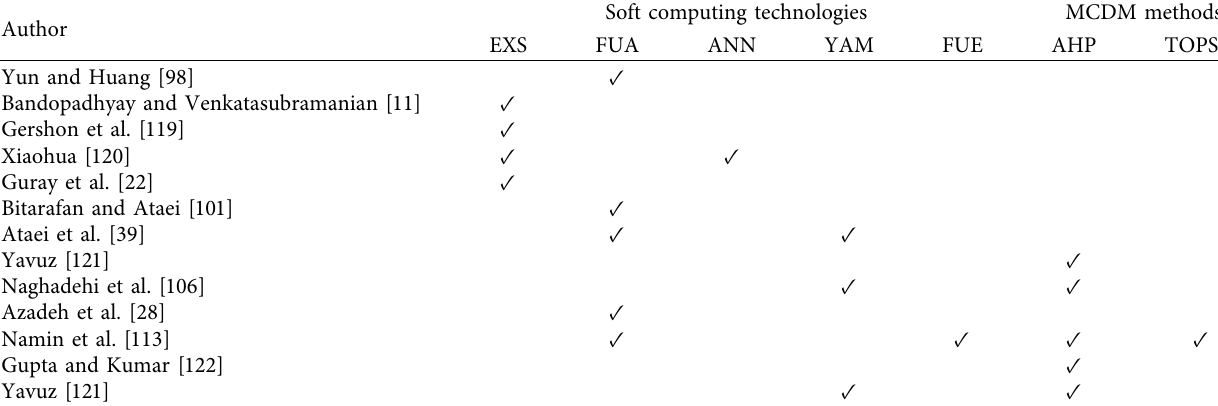
Table 3: Summary of first representative MMS studies using SC technologies and MCDM